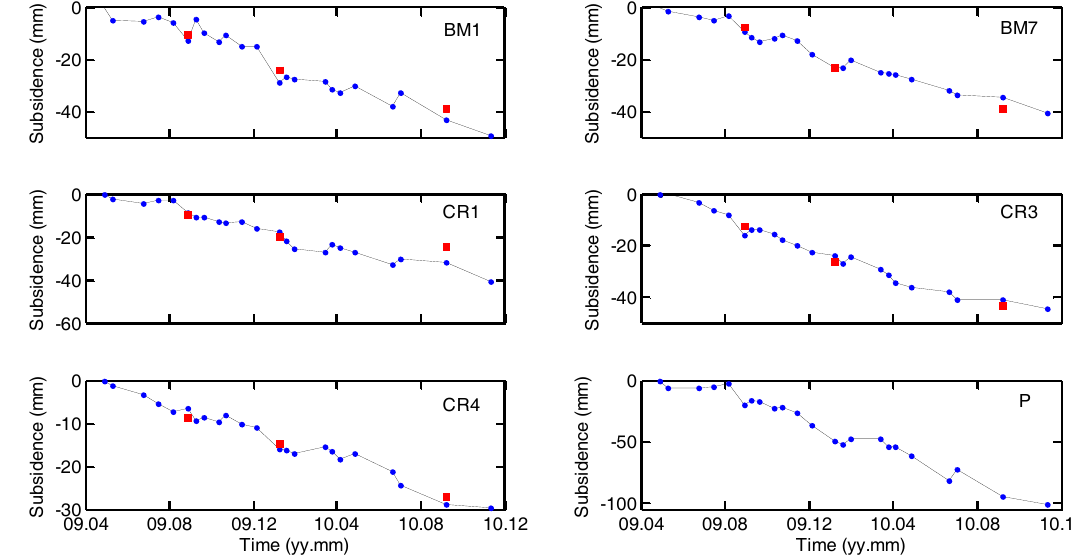
Figure 6. Time series of subsidence derived at two BMs, three CRs and the maximum subsidence point P using the 23 USB interferometric pairs. Note that yy.mm stands for year.month, and one can read 09.04 as April of 2009, for example.